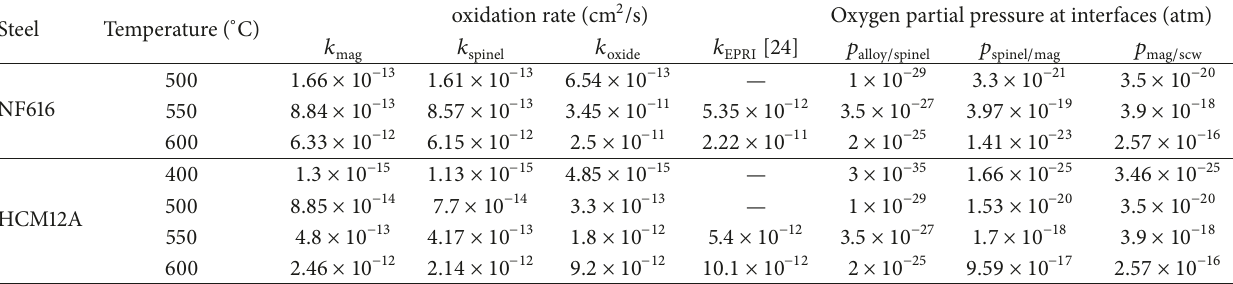
, and oxygen partial pressure of